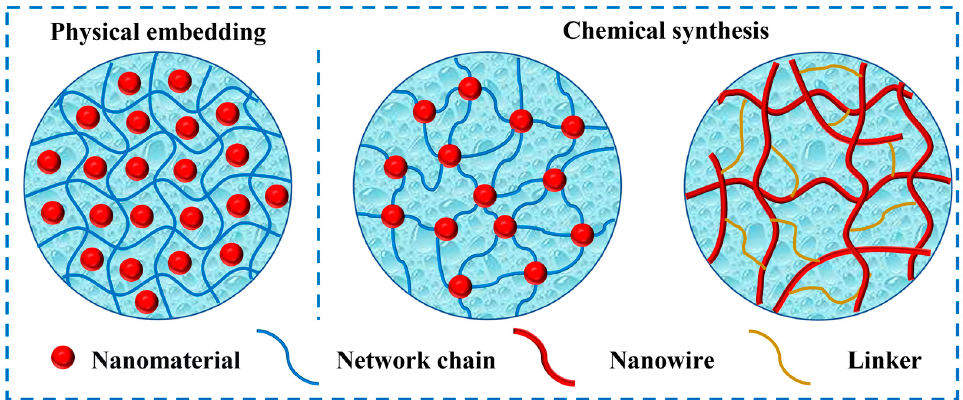
Figure 1. Schematic of fabrication strategies of physical embedding and chemical synthesis of NMFHs.